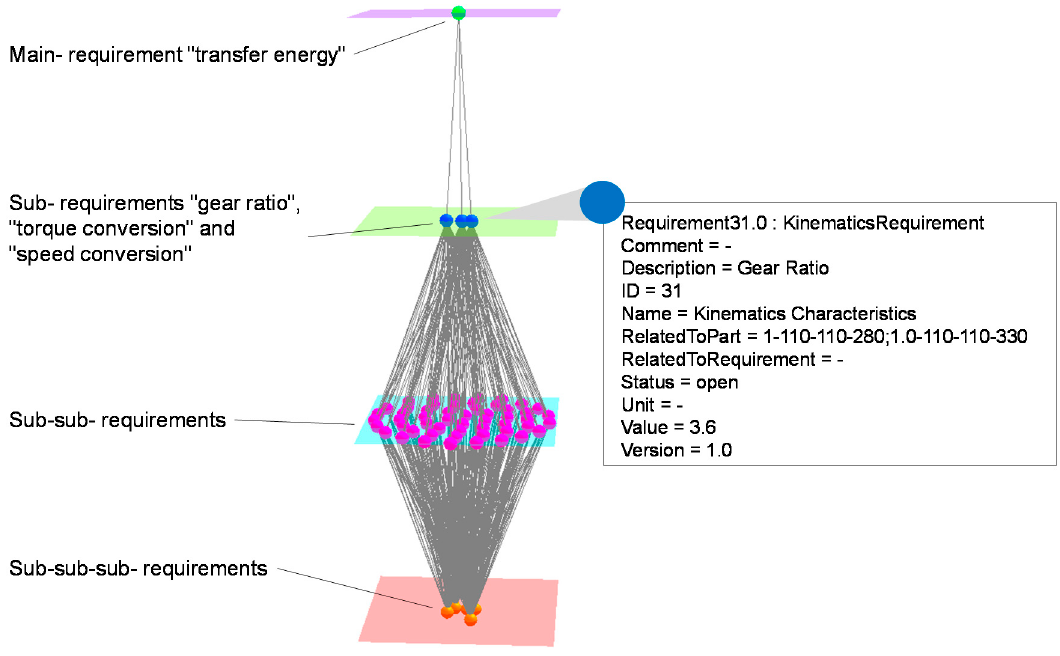
Figure 14. Polyhierarchy of requirements from the database.